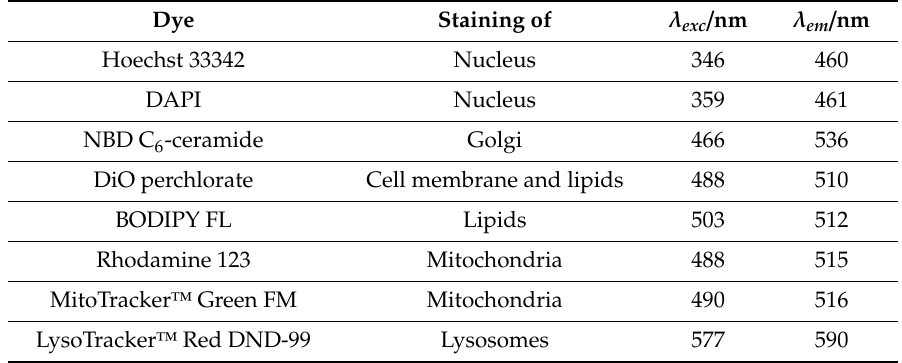
Table 1. Commonly used dyes for fluorescence cell staining, organelle where the dye accumulates, and excitation and emission wavelength peaks [108].